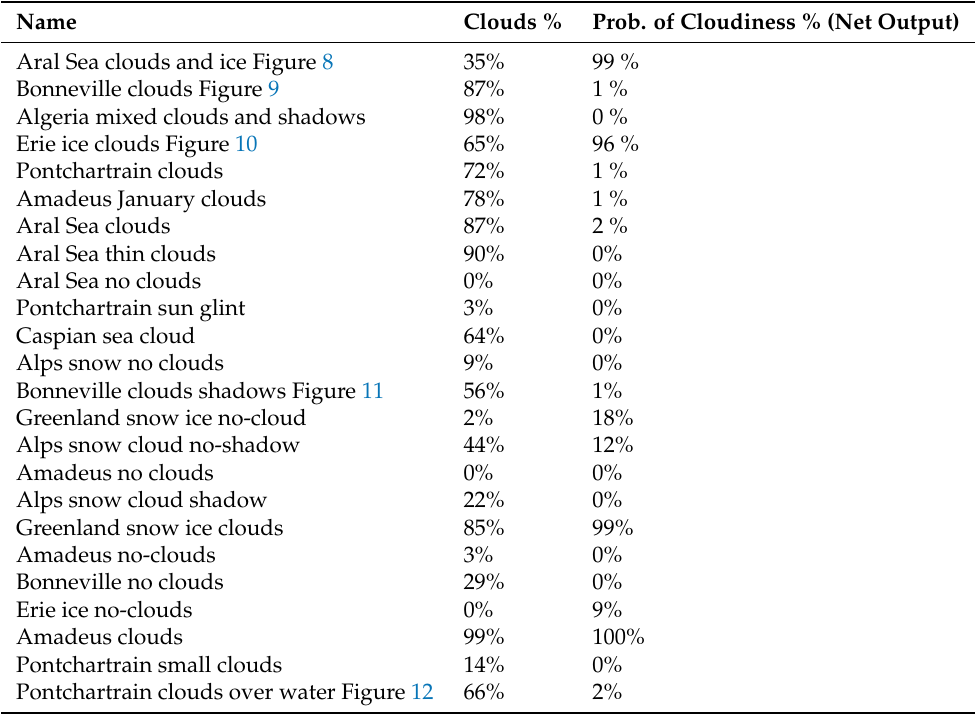
Table 7. The critical test set